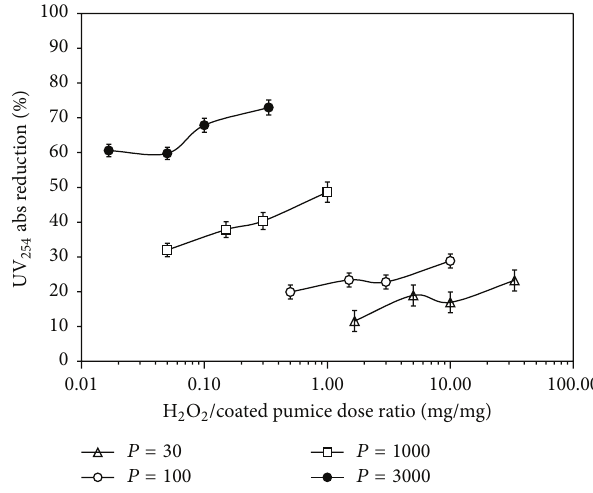
Figure 4: The effects of H 2 O 2 /iron oxide-coated pumice dose ratio (mg/mg) on NOM removals in MB water. < 63 𝜇 m iron oxide-coated Isp pumice: pumice dosages in the legend are in mg/L. Error bars indicate the 95% confidence intervals.